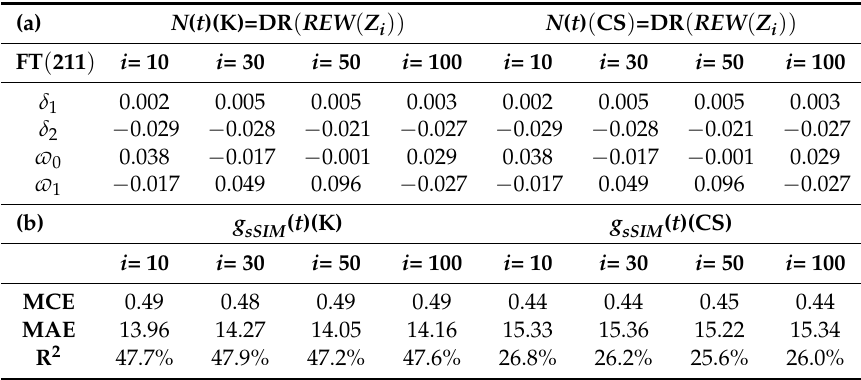
Table 3. Parameters and indicators for the dynamic regression (DR) analysis. ( a ) Estimation of the TF(2,1,1) coefficients with seasonal adjustment (K) and complete series (CS) incorporating the VWC records at different depths in the root zone. ( b ) Efficiency criteria of the g sSIM models obtained, where R 2 is the coefficient of determination; MCE, modified coefficient of efficiency; MAE, mean absolute error, calculated with respect to the observed g s values; Z i , soil depth (in